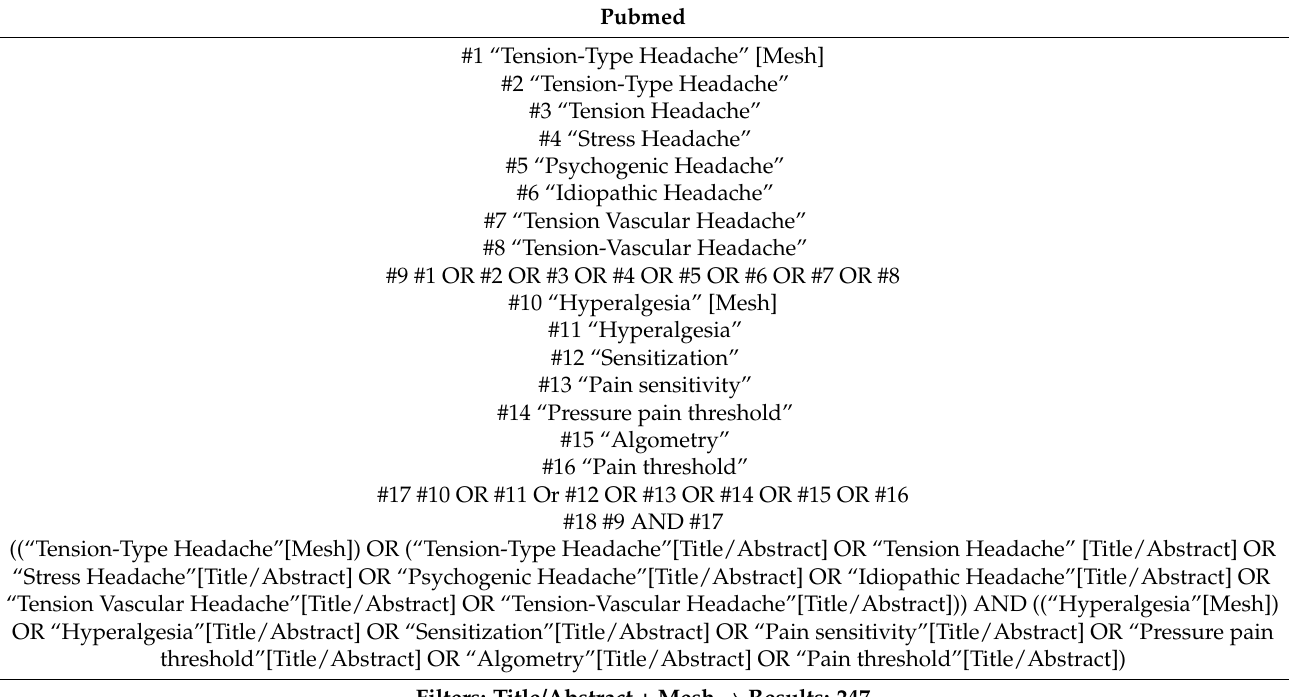
Table 1. Search Strategy for Tension-Type Headache